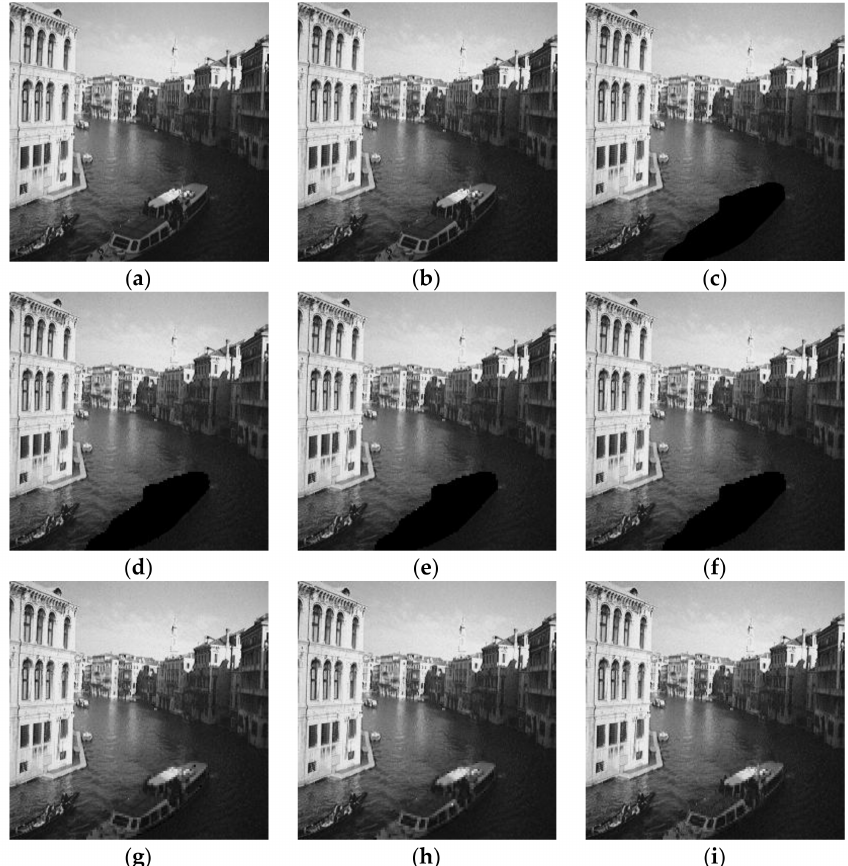
Figure 9. Tamper detection and recovery performance for image deletion attack: ( a ) Original Venice image; ( b ) watermarked Venice image; ( c ) attacked image; ( d ) tamper detection result using the method in [13]; ( e ) tamper detection result using the method in [25]; ( f ) tamper detection result of the proposed method; ( g ) image recovery result using the method in [13]; ( h ) image recovery result using the method in [25]; ( i ) image recovery result of the proposed